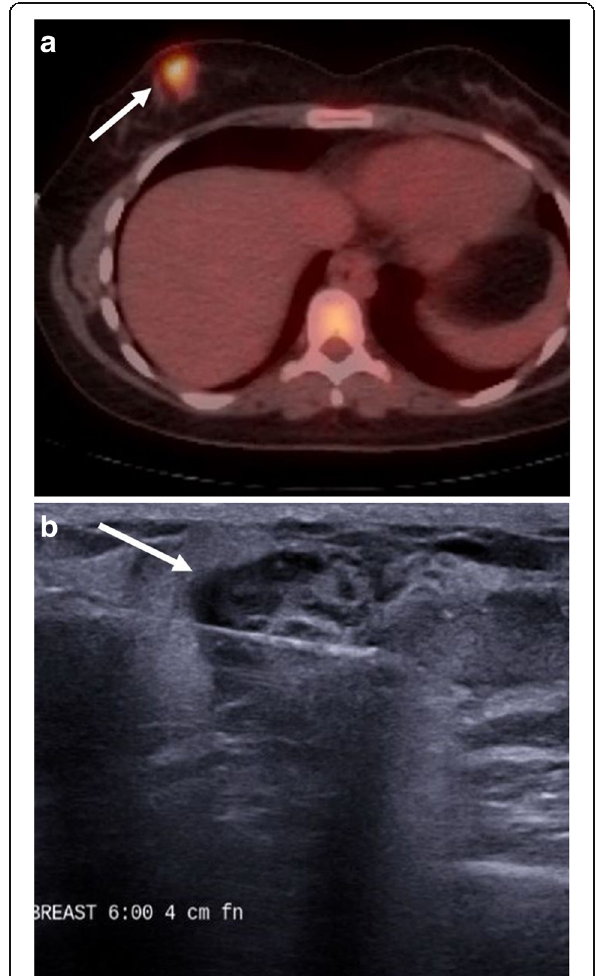
Fig. 10 Breast involvement. A 22-year-old female with known Burkitt lymphoma. a Staging fused axial PET-CT demonstrates hypermetabolic activity within the inferior and medial right breast (arrow). b Grayscale ultrasound during percutaneous biopsy demonstrates an irregular, heterogeneous mass with indistinct margins (arrow). Biopsy results revealed Burkitt